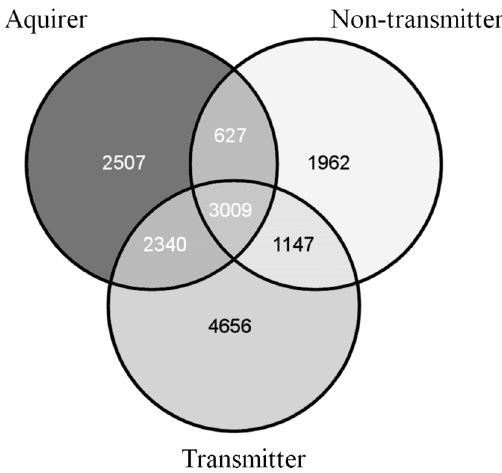
Figure 2. Venn diagram showing the partitioning of the 16,248 fixed homozygous polymorphisms detected among G. nigrifrons transmitters, acquirers, and non-acquirers.